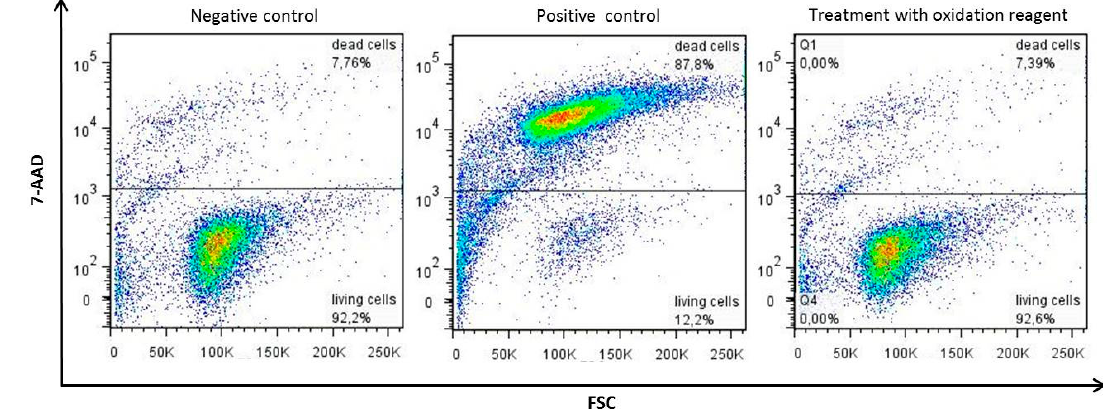
Figure A2. Oxidation does not impair the viability of NKL cells. The impact of the mild oxidation of on the viability of the target cells was validated. NKL cells were treated with 1.5 mM NaIO4 oxidation reagent for mild oxidation. Dead cells are stained with 7-AAD.